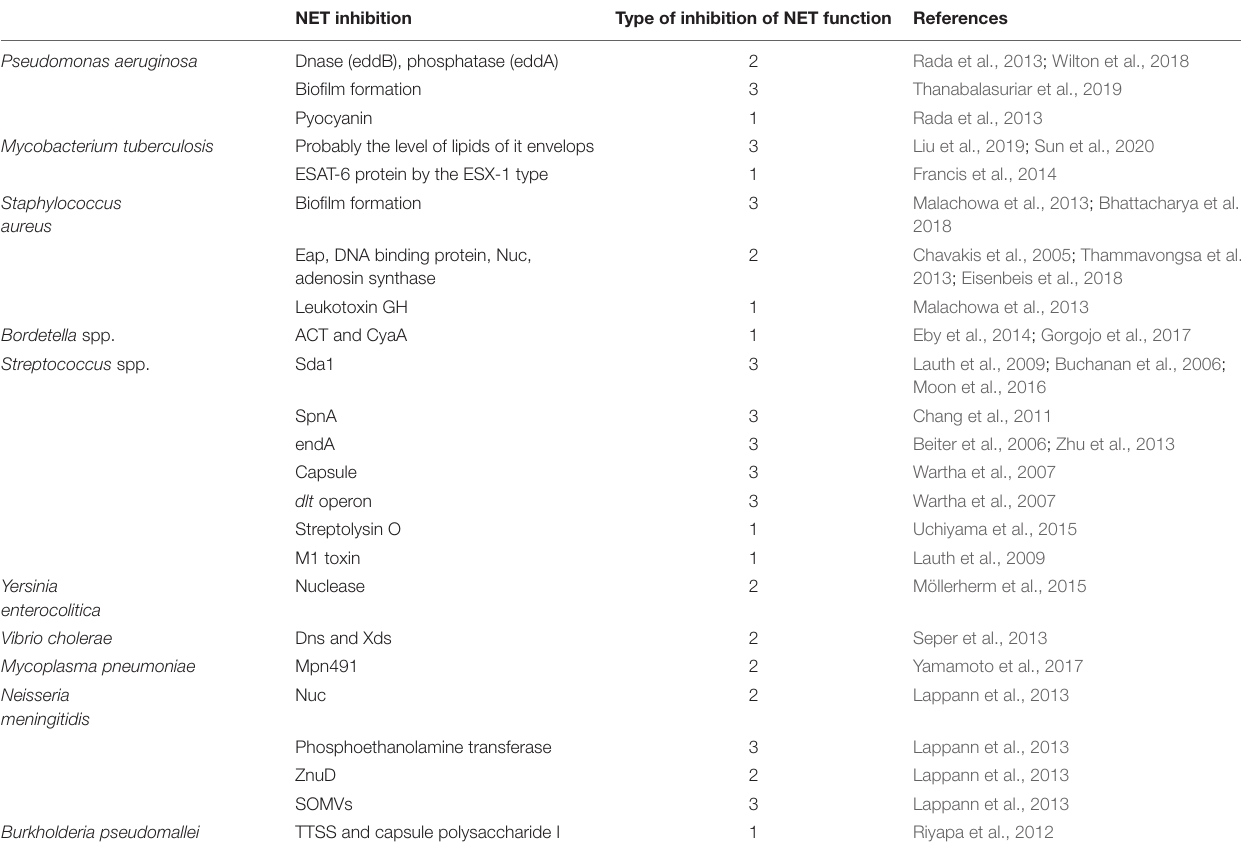
TABLE 1 | Virulence factors that interfere with NET function during bacterial